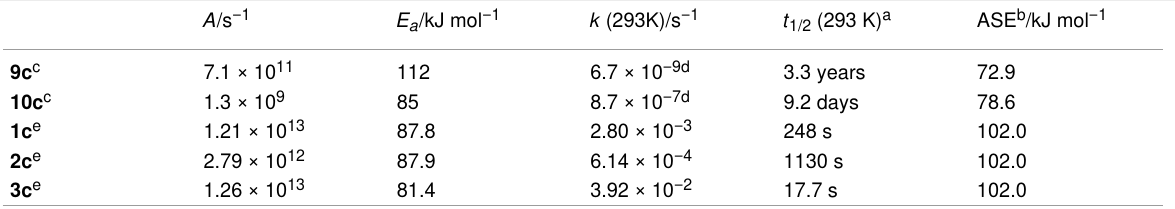
Table 3: Kinetic data of thermal back reactions and aromatic stabilization energy of 1c – 3c , 9c and 10c